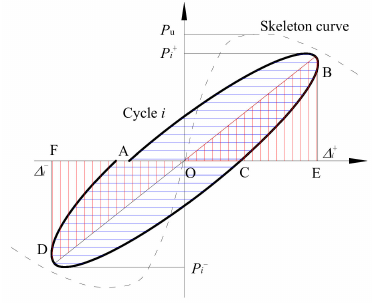
Figure 9. Diagram of energy dissipation.